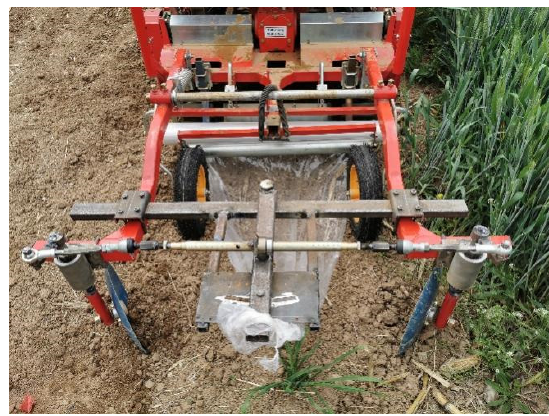
Figure 6. The adjusting